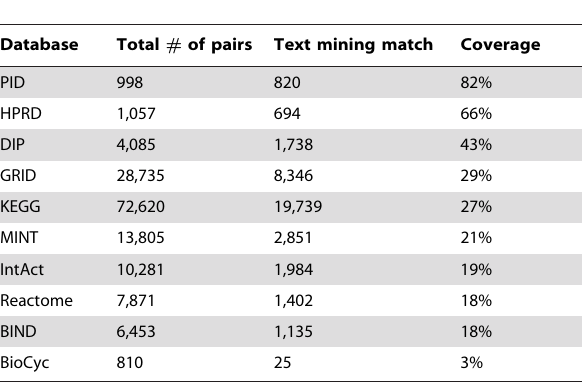
Table 6. Data integration